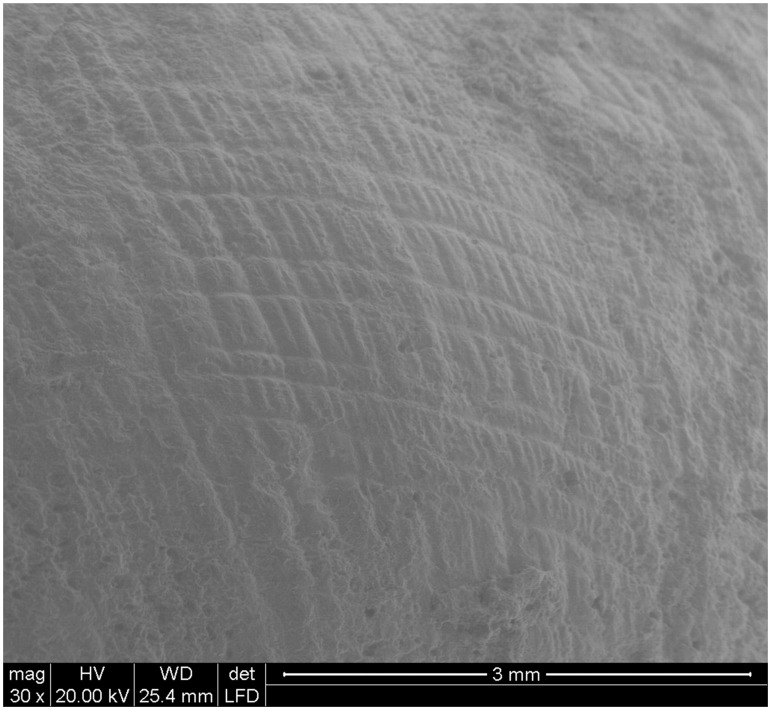
SEM microscope image showing the characteristic reticular sculpture of the genus Iberus shells.